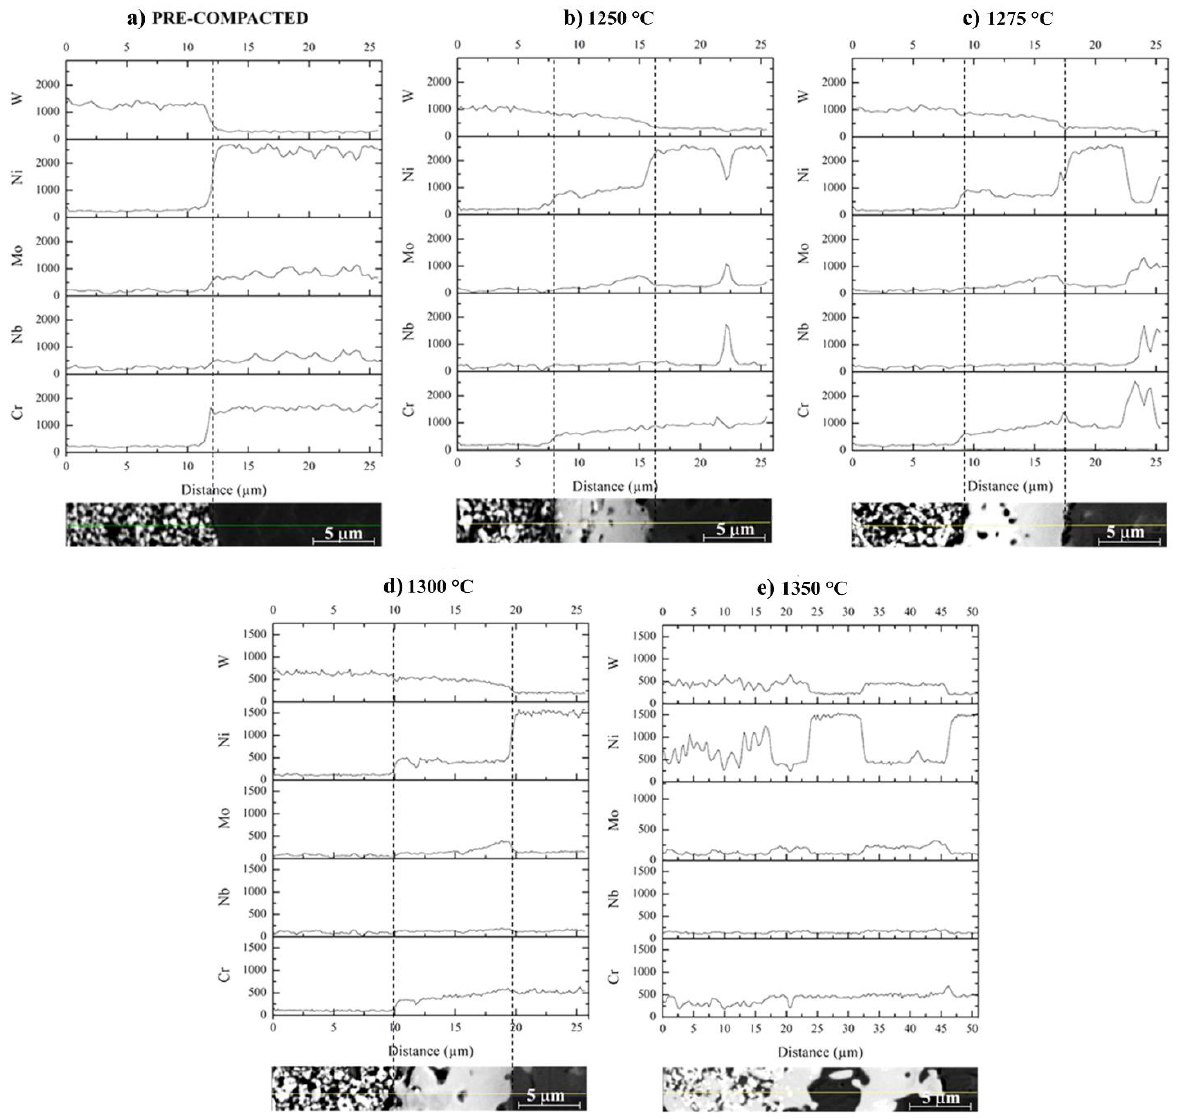
Figure 4. Line scan profiles of the different elements in the interaction area shown in the images, of WC–IN625 in the pre-compacted condition ( a ) and after sintering at 1250 °C ( b ), 1275 °C ( c ), 1300 °C ( d ) and 1350 °C ( e). During sintering at 1350 °C, IN625 melts and all the elements spread into the sur- rounding areas. The concentration profiles show that the black areas in the microstructure are rich of Ni (superalloy), which is different than those in the gray areas where W is the main element. Mo, Nb and Cr seemed to be homogeneously distributed. The Mo and Cr peaks in the same points highlighted the presence of a (Cr,Mo)-rich phase, perhaps a (Mo,Cr) 23 C 6 carbide. To define the phases present after the different sintering cycles, Figure 5 shows the XRD spectra.